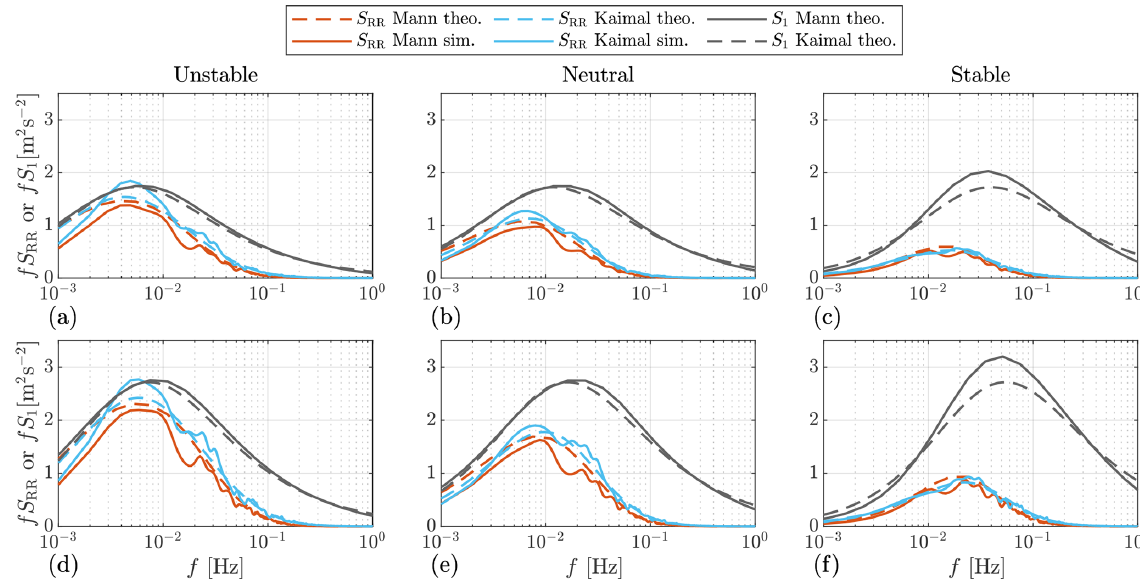
Figure 10. The auto-spectra of REWS. “theo.”: theoretical spectra by the models discussed in Sect. 3, i.e., Eqs. (25) and (26). “sim.”: the spectra estimated from the time series of the turbulent wind fields in OpenFAST simulations, using the Welch (1967) method. S 1 : the auto-spectra of a single-point u component. Panels (a) – (c) have a mean wind speed of 16ms − 1 . Panels (d) – (f) have a mean wind speed of 18ms − 1 .